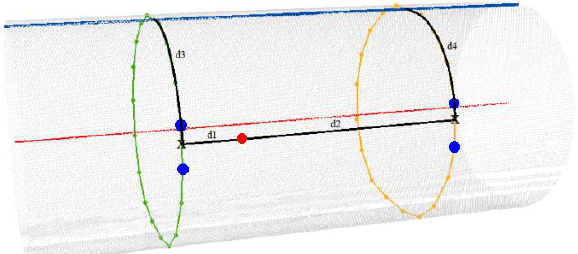
Figure 11. The distance between the point in analysis and the top of the tunnel (blue line) along the two cross-sections (black arcs), calculated by a weighted average of the two